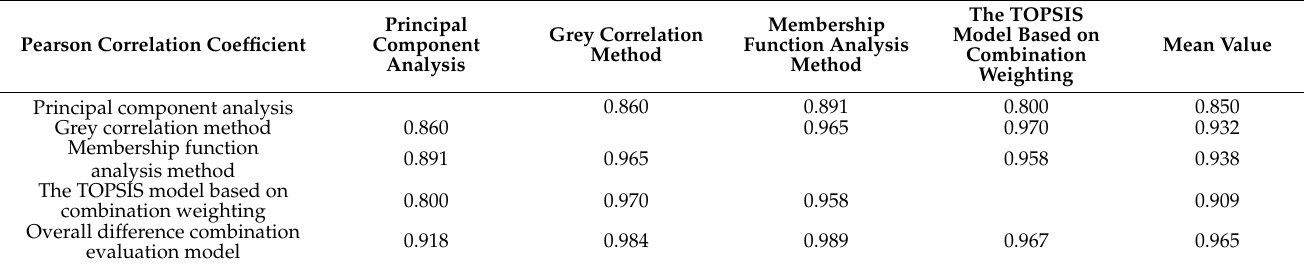
Table 5. Pearson correlation coefficient of evaluation value of each evaluation